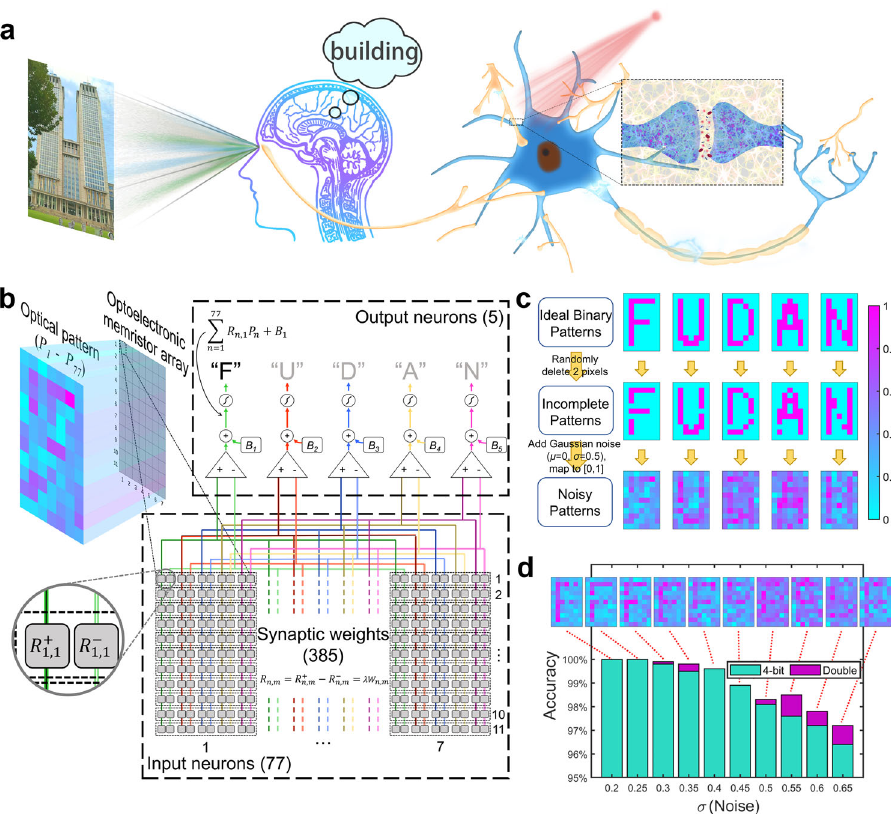
Fig. 6 Biological vision process and the ANN for sensing and recognition. a A biological visual illustration is depicted, focusing on the details of nerve cell signaling as well as synaptic connections. b The structure and principles of the ANN image sensor. c The process of creating pseudo optical patterns. d The classi fi cation accuracy decreases with the noise growth. The green bar indicates the accuracy after 4-bit weight quantization, and the purple bar indicates that of an unquantized model. The image above is a representation of the ‘ F ’ image corresponding to the different σ . The dataset includes fi ve letters with 200 samples